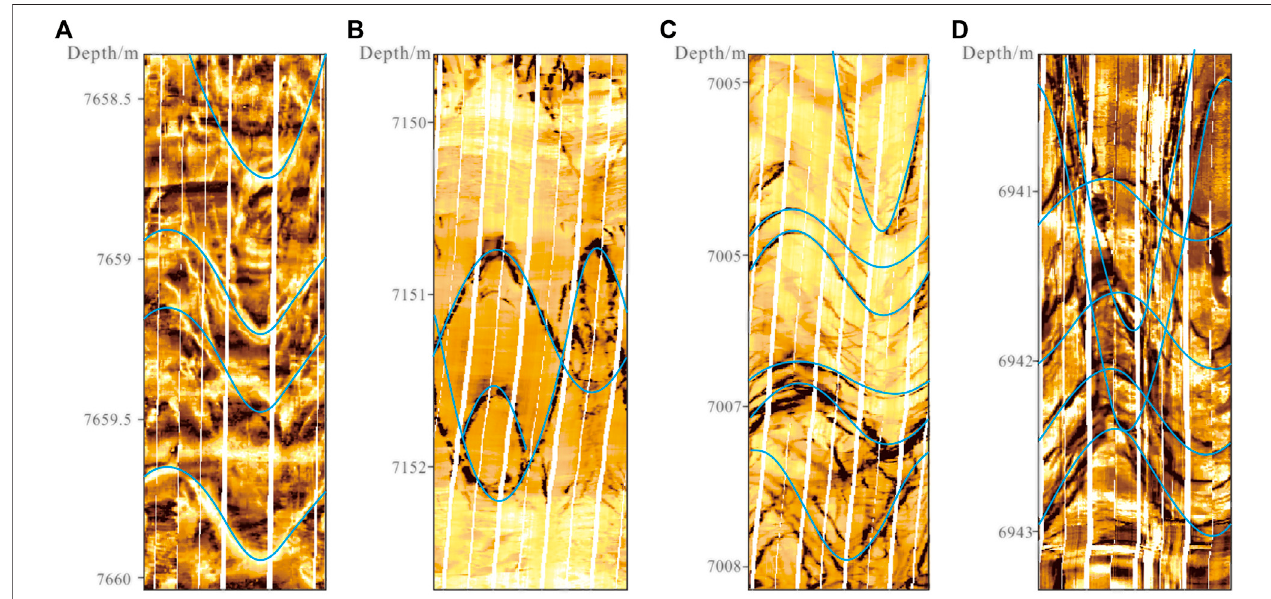
FIGURE5|(A) WellZ2,7,658 – 7,660 m,agroupofnearlyparallelfractures; (B) WellZ1-1,7,150 – 7,152 m,reticularfracture; (C) WellZ13,7,005 – 7,008 m,thewell wall is fragmented, with a series of fractures with different dip angles; (D) Well Z104, 6,941 – 6,943 m, reticular fractures composed of high angle fractures and medium and high angle